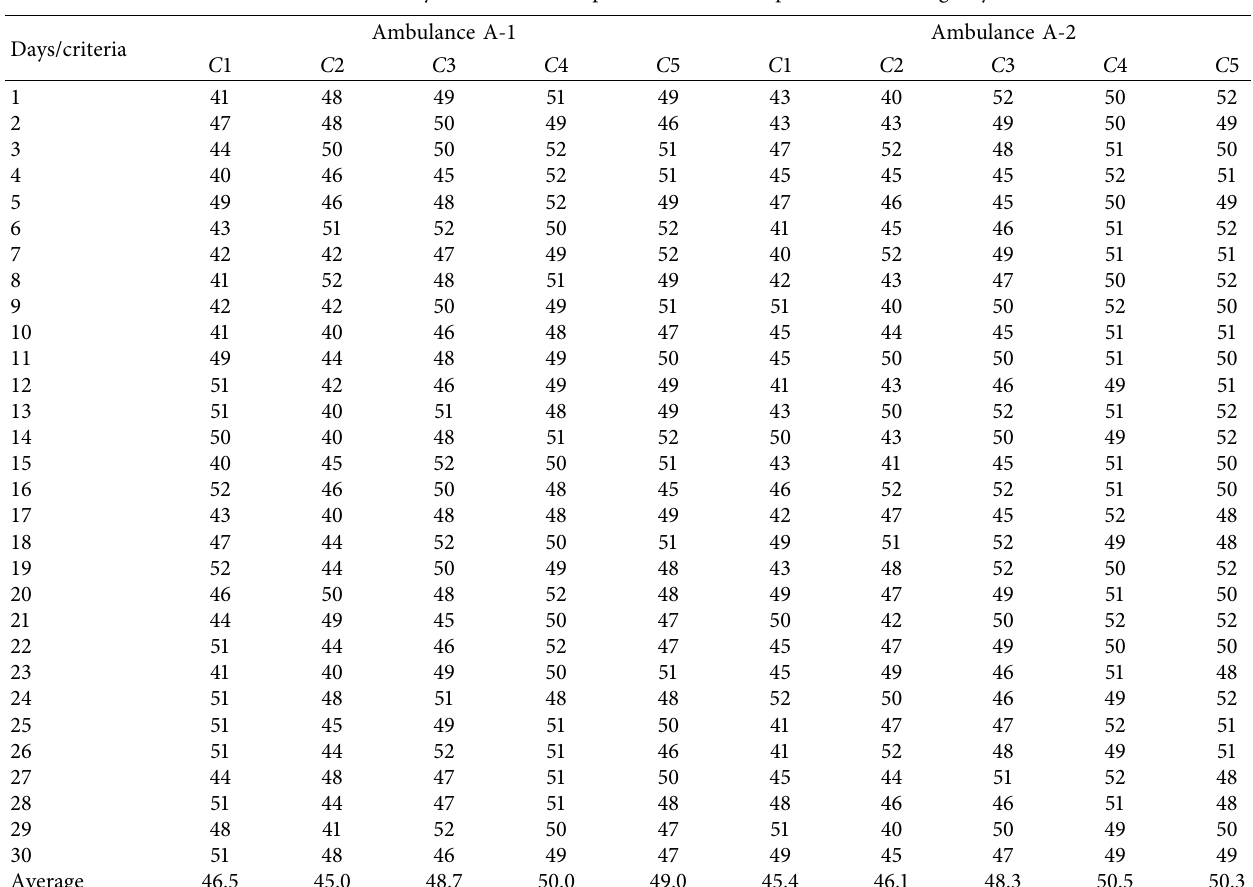
Table 4: Evaluation of daily missions in compliance with health protocols in emergency center A. Days/criteria